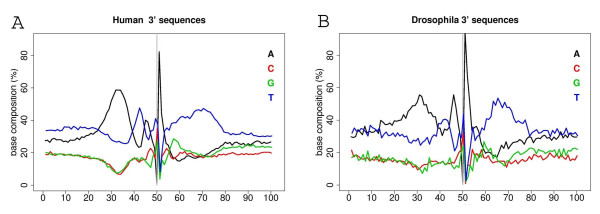
Nucleotide composition profile is conserved between human and Drosophila cleavage sites. A: Human ESTs (590008). B: Drosophila ESTs (11385). CS at position 50 is marked by a gray line.